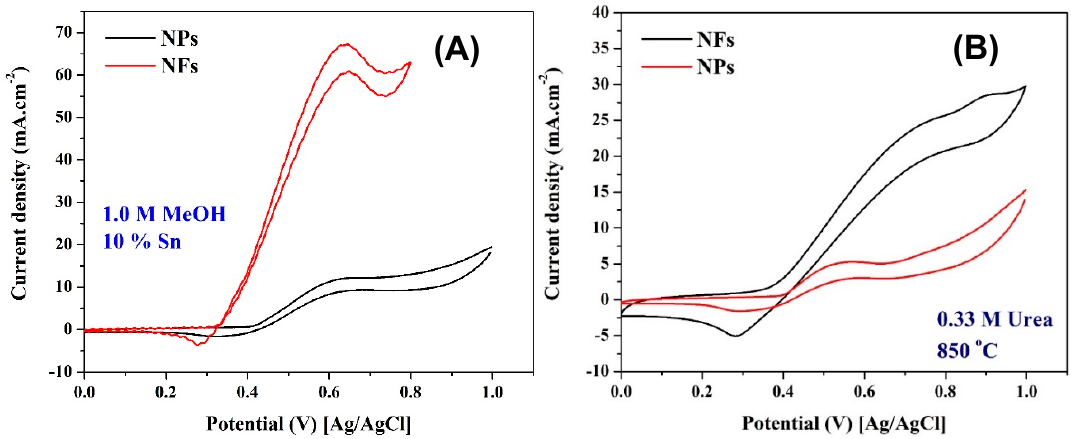
Figure 12. Influence of the nanostructural morphology on the electrocatalytic activity of 10 wt % Sn nanofibers prepared at 850 °C toward oxidation of methanol (1.0 M in 1.0 KOH) ( A ) and urea (1.0 M in 1.0 KOH); ( B ) the measurements were performed at room temperature and a scan rate of 50 mV/s.